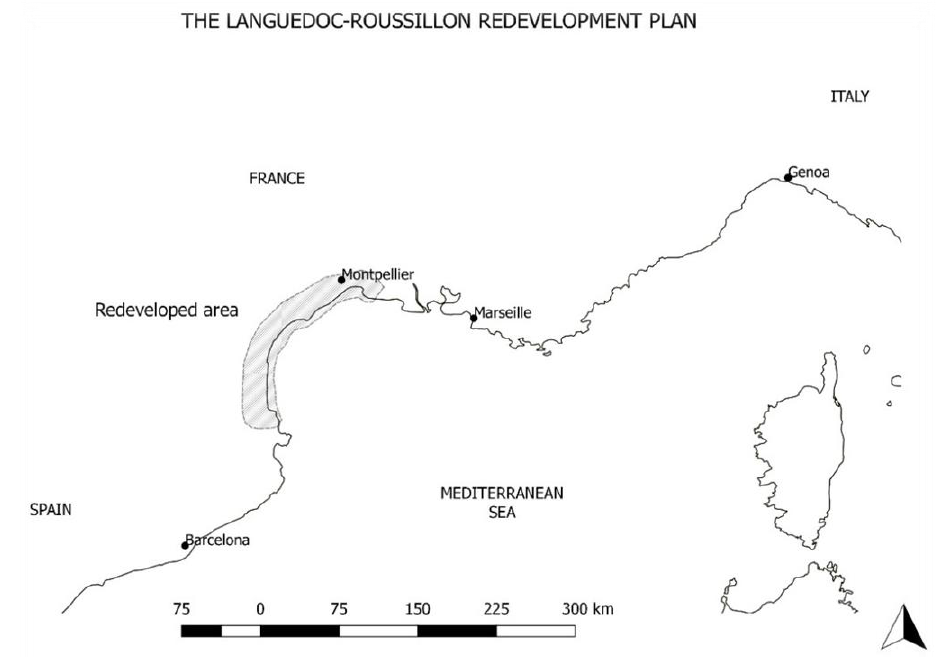
Figure 1. The redeveloped coast of Languedoc-Roussillon. Cartography by the author.